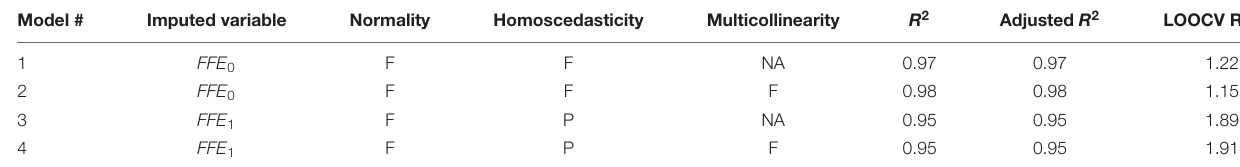
TABLE 7 | Model evaluation results for regression models.